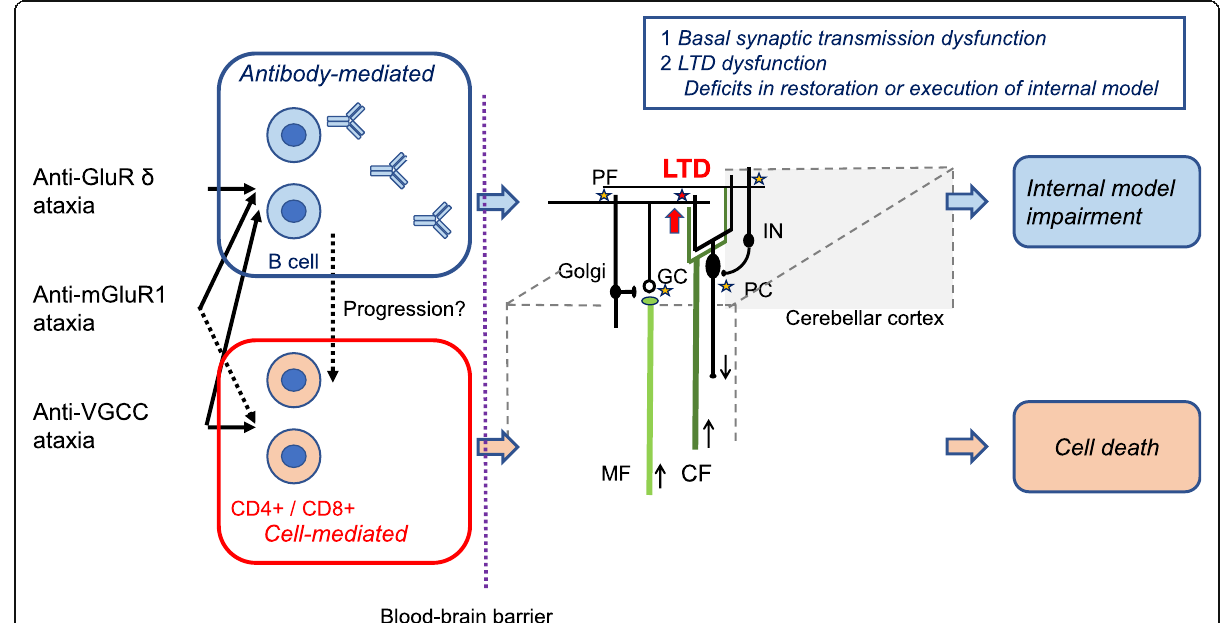
Fig. 1 Schematic diagram of the pathophysiological mechanisms underlying anti-VGCC, anti-mGluR1, and anti-GluR delta-associated cerebellar ataxias. The antibody-mediated mechanisms include dysfunction of basal synaptic transmissions and long-term depression (LTD), leading to impairment of the internal model. These functional disorders are followed by cell-mediated cell death, depending on the auto-immune stimulus. PC; Purkinje cell, GC; granule cell, IN; inhibitory interneurons, CF; climbing fiber, PF; parallel fiber, MF; mossy